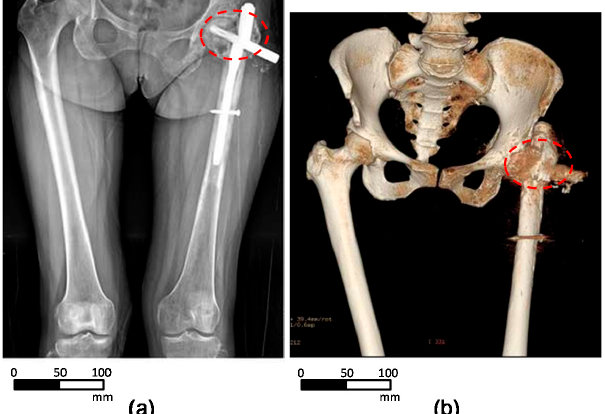
Figure 1. Pre-operative medical images of the pelvis area obtained from the patient: ( a ) plain radiograph and ( b ) 3D computed tomography (CT) images.